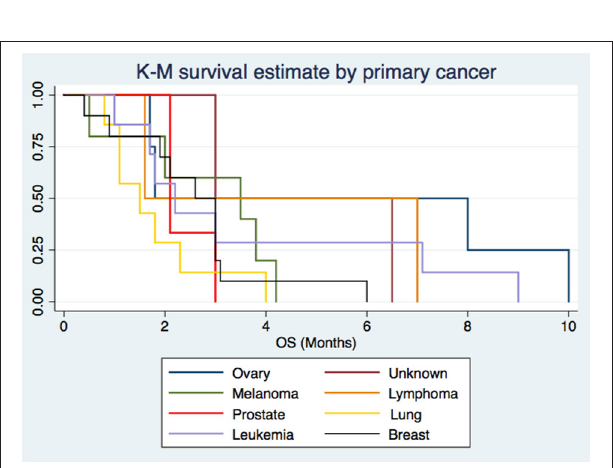
FIGURE 2 | The origin of Leptomeningeal Carcinomatosis by primary cancer.